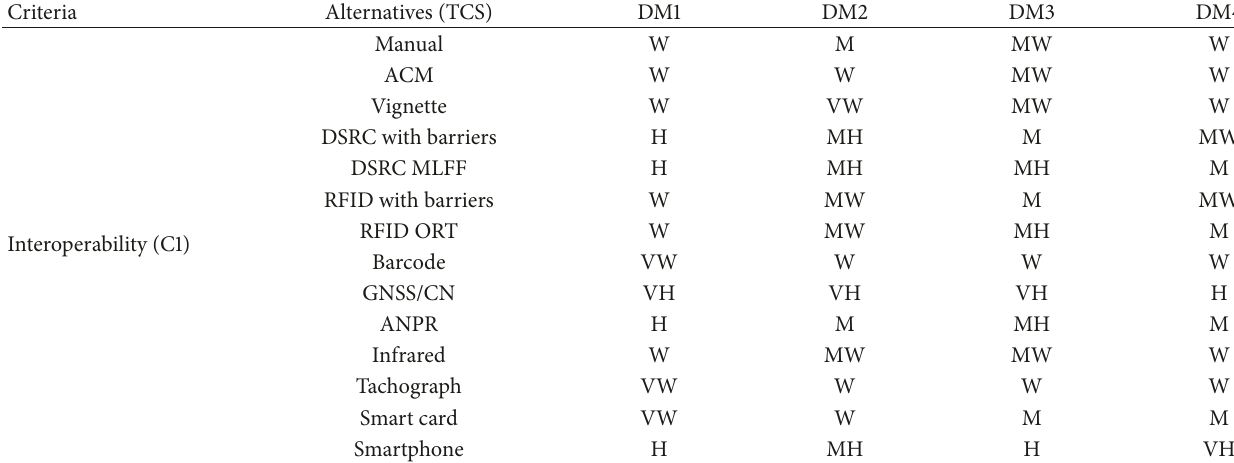
Table 7: The opinion of decision makers for each alternative on the basis of criterion “Interoperability”.